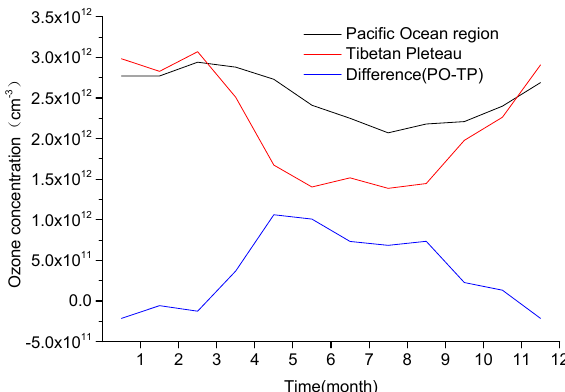
Figure 1. Monthly mean variation curve of ozone number concentration at 18 km observed by satellite (black: the Pacific Ocean region (25–40° N, 140–180° E); red: the Tibetan Plateau (25–40° N, 70–110° E); blue: the quantitative difference between the preceding two curves (PO-TP)).